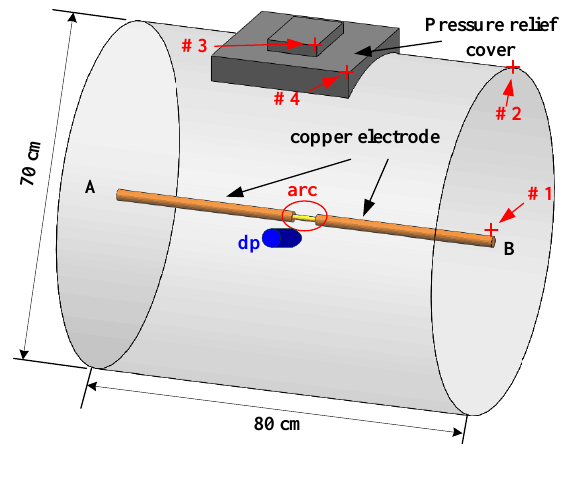
Figure 8. Closed container.